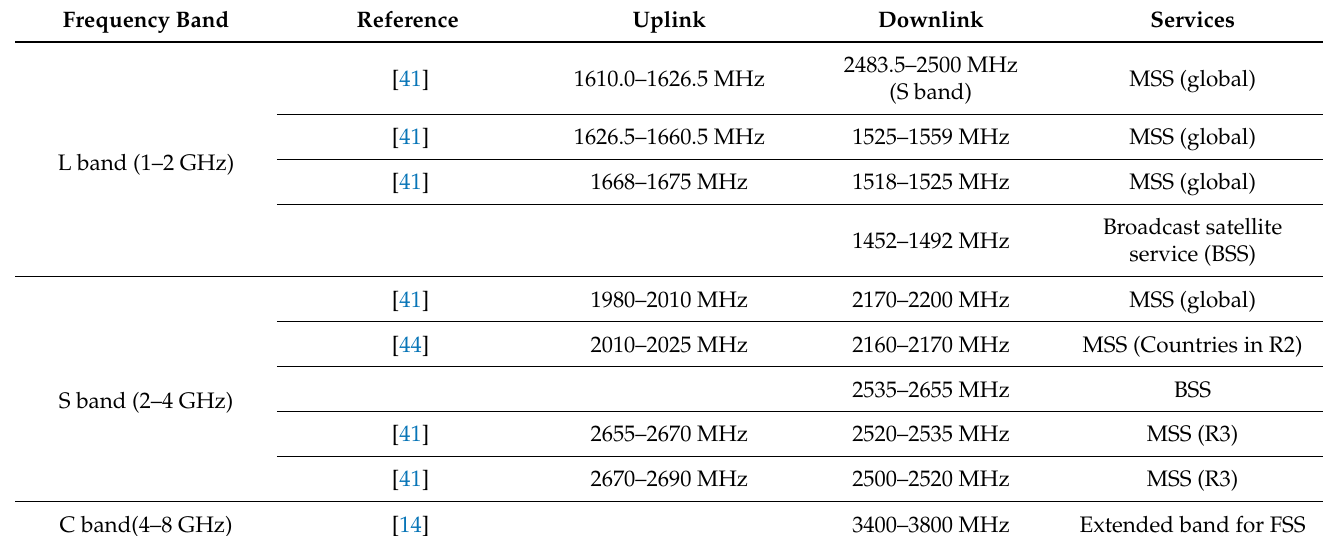
Table 5. Spectrum usage of satellite